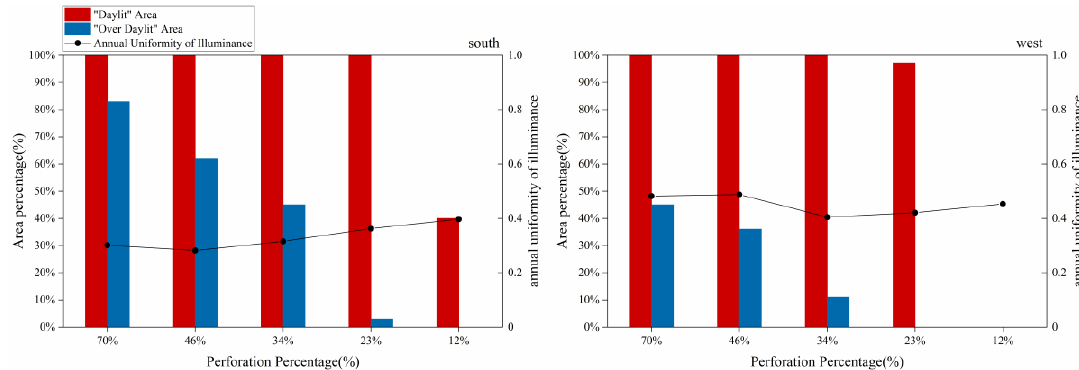
Figure 8. Radiance rendered views for a PP of 20% in the south-facing orientation and 50% in the west-facing orientation at 12:00 p.m. 21 December (standard meteorological year).